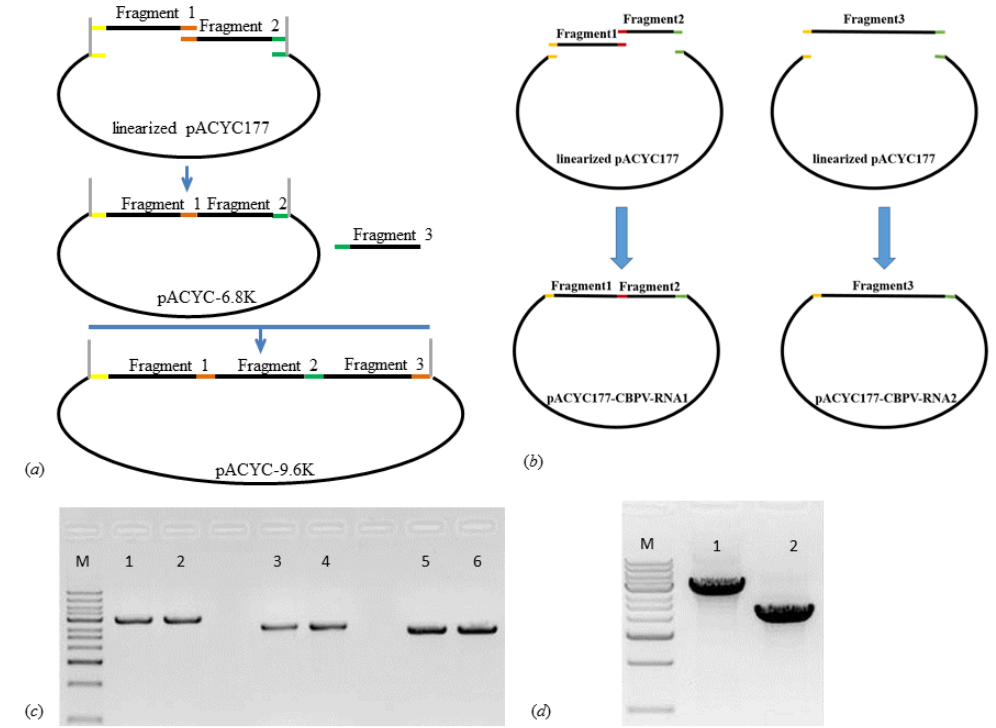
Figure 1. Schematic diagrams of the infectious clones for Israeli acute paralysis virus (IAPV) and chronic bee paralysis virus (CBPV). The steps for construction the infectious clones of IAPV ( a ) and CBPV ( b ). PCR amplification target fragments of IAPV ( c ) and CBPV ( d ). M indicates the DNA ladder. Numbers 1–6 in Figure c indicate fragment 1 (lanes 1 and 2), fragment 2 (lanes 3 and 4), and fragment 3 (lanes 5 and 6) of IAPV. Numbers 1–2 in Figure d represent fragment 1 and 2 of RNA 1